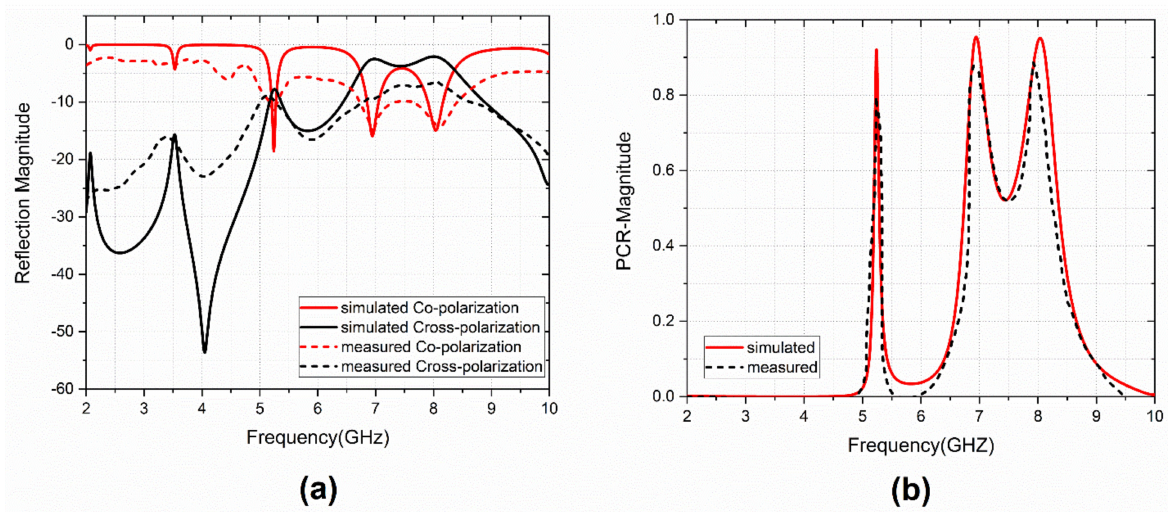
Figure 14. Comparison between simulated and measured results: ( a ) reflection magnitude, ( b ) PCR.